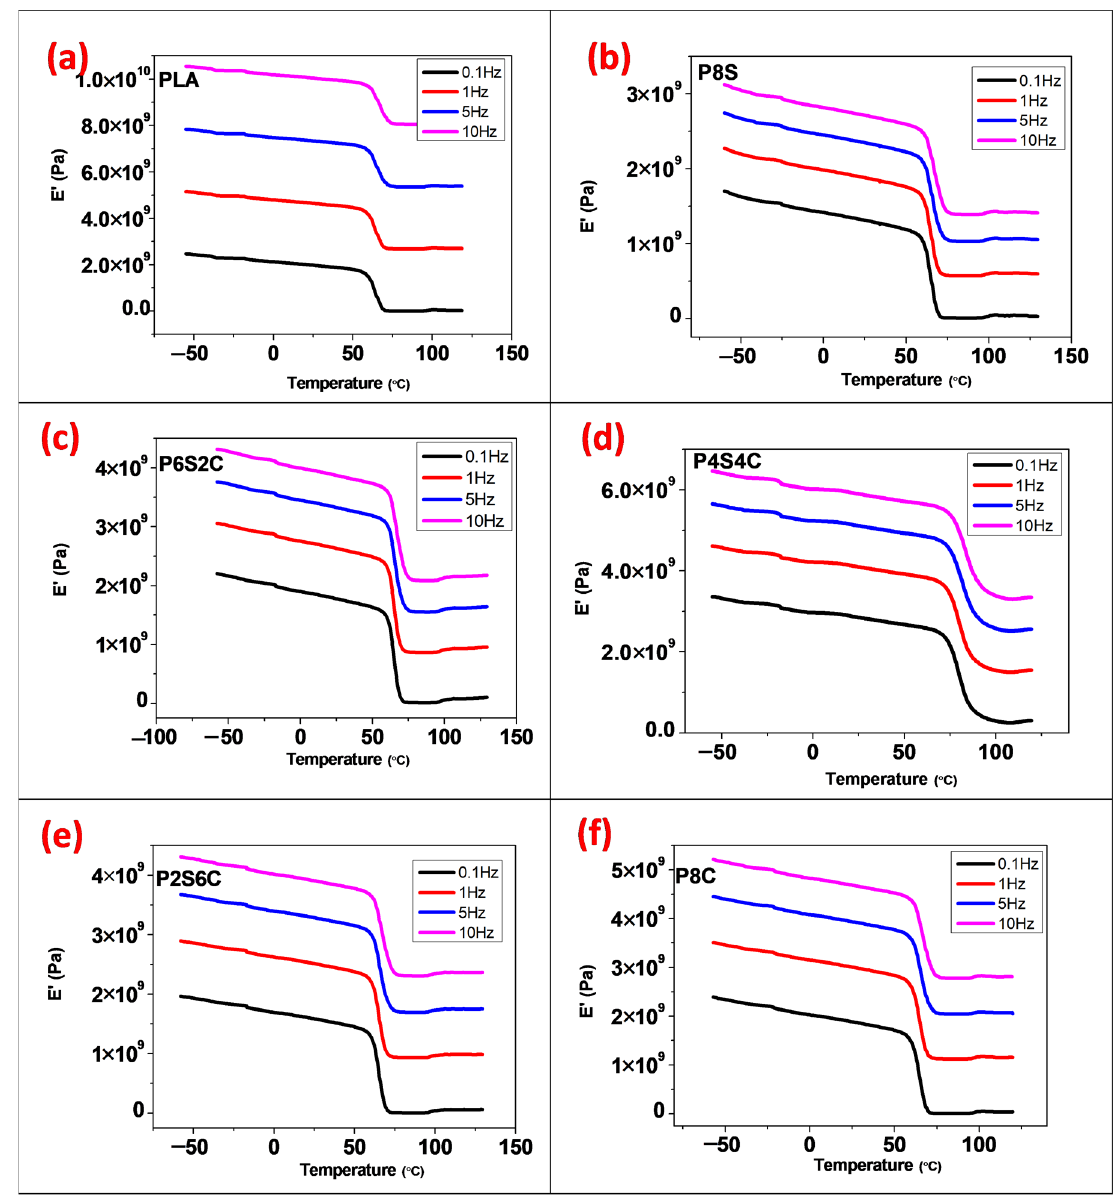
Figure 3. The effect of frequency on DMA storage modulus curves of the ( a ) PLA, ( b ) P8S, ( c ) P6S2C, ( d ) P4S4C, ( e ) P2S6C and ( f ) P8C